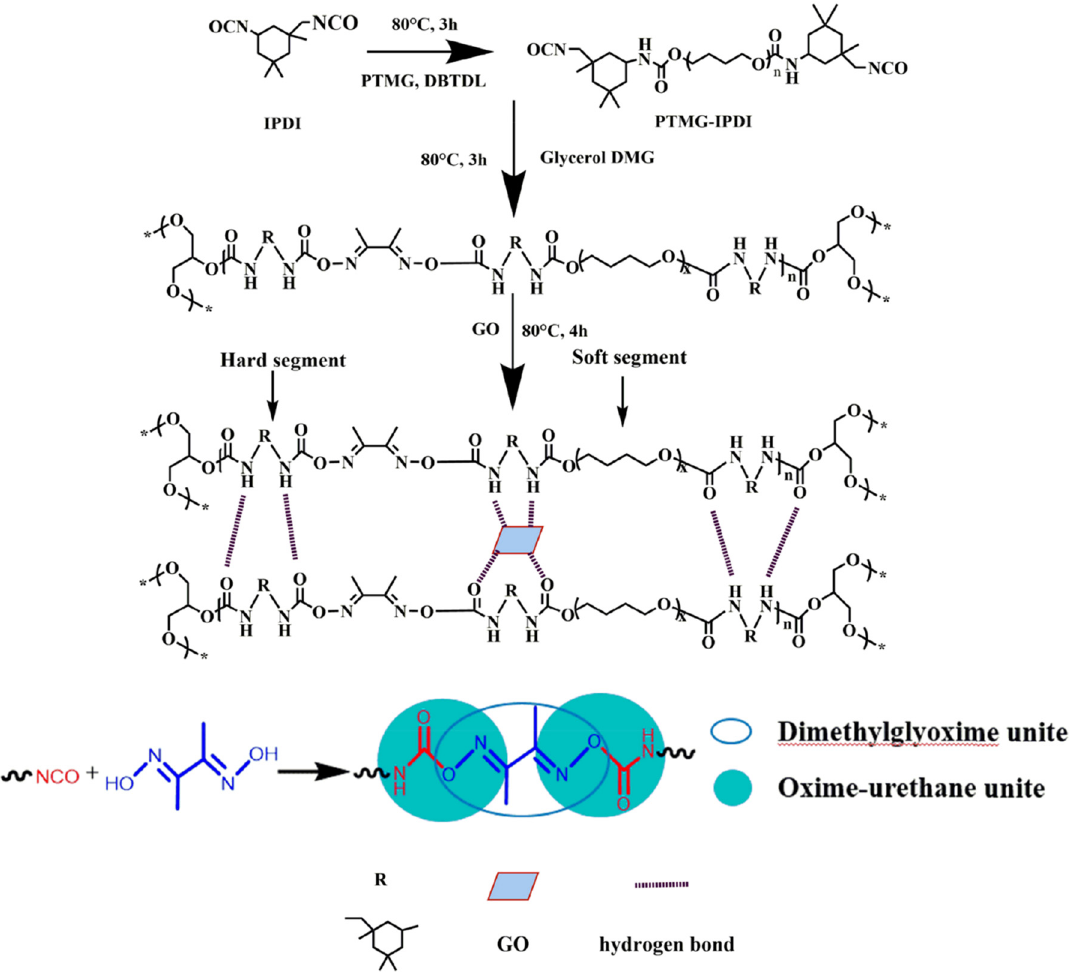
Figure 3: Schematic illustration for the preparation of PU - GO composites. Copyright 2021, John Wiley & Sons – Books ( 72 )